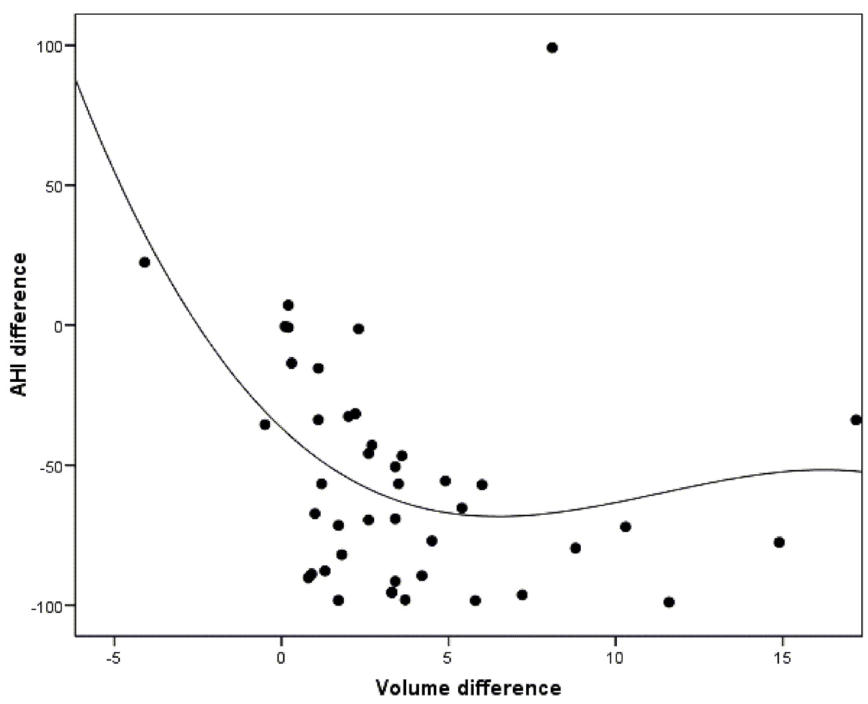
Figure 7. Correlation between the changes in AHI after MAD titration and the volumetric changes in the upper airway ( p = 0.007).